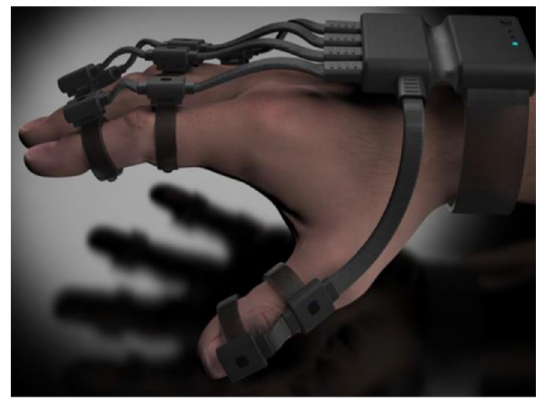
Figure 26. VR glove